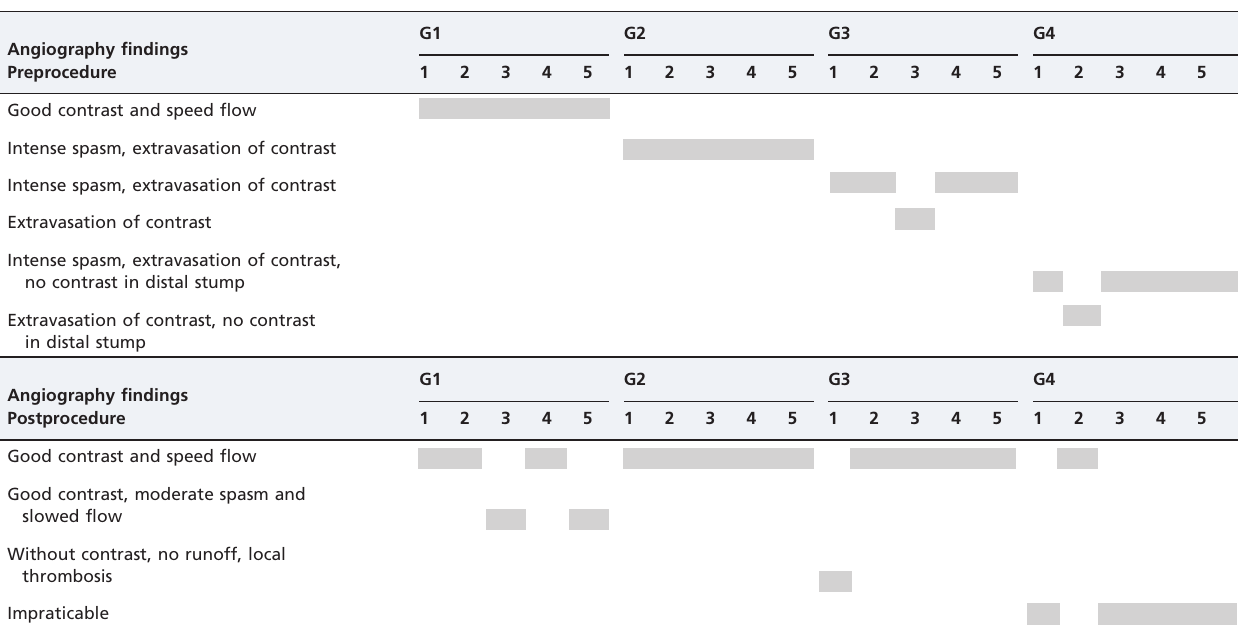
Table 3 - Arteriography findings before and after the endovascular procedure to place the covered stent in the left common carotid artery in control and experimental